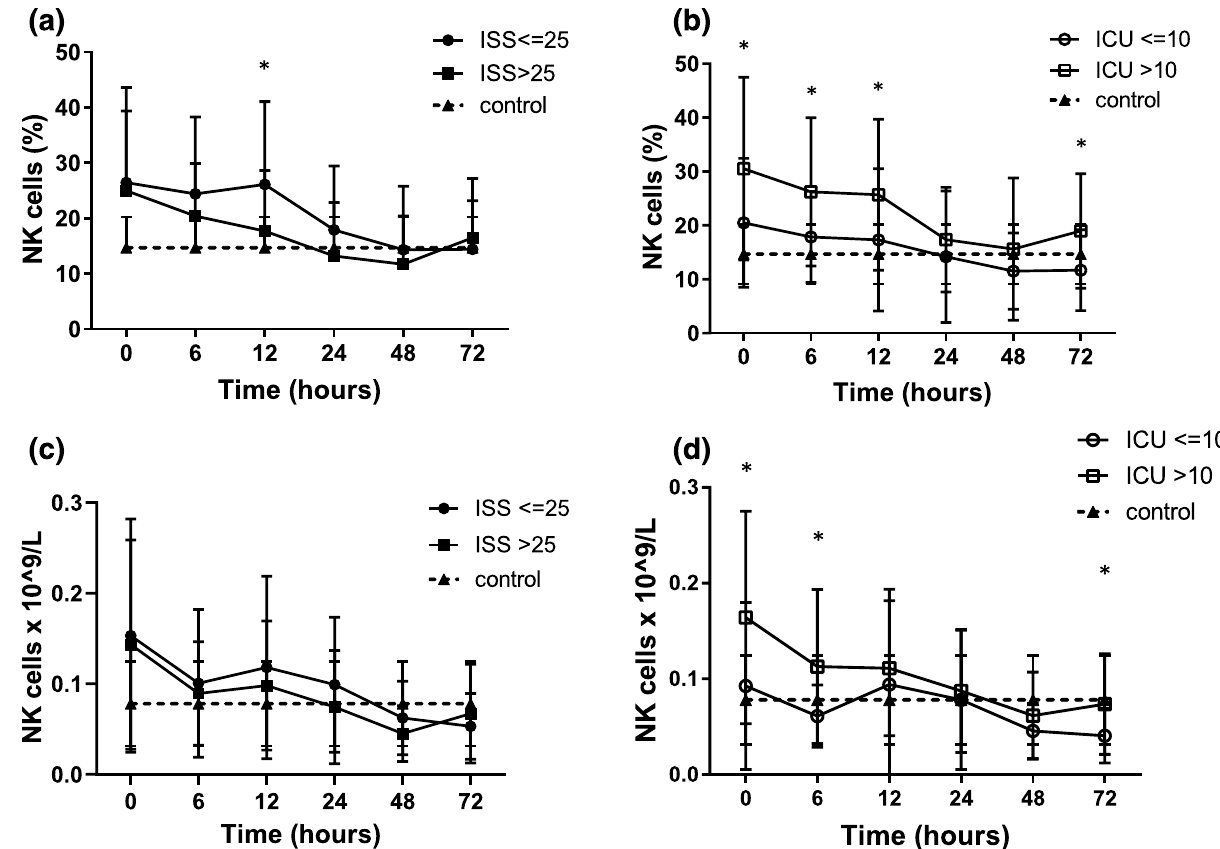
Figure 3. NK cells in trauma patients. ( a ) Patients with an ISS ≤ 25 had higher percentages of NK cells compared to those with an ISS > 25. ( b,d ) Patients with a long ICU stay had increased NK cells compared to that with a short ICU stay. ( c ) The NK cells in trauma patients grouped by ISS, * p <